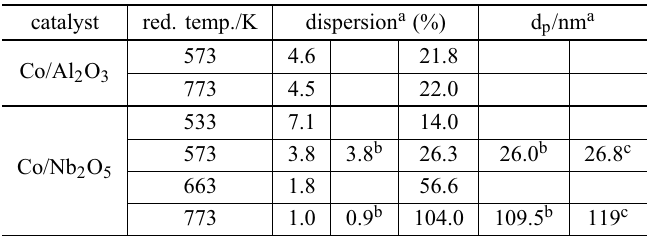
Estimation of dispersion and particle sizes of catalysts. The disper- sions and the particle sizes were calculated assuming that the degree of the reduction, for both temperatures, is ca. 100% with cobalt loading of 4.49 wt.% for Co/Nb 2 O 5 and 4.5 wt.% for Co/Al 2 O 3 . The dispersions and the particles sizes were calculated assuming the nominal cobalt loading (5 wt.% Co) and the degree of reduction obtained from magnetic measurements. Values measured accord- ing to procedure 2 (Rosenir et al. 1993). catalyst red.